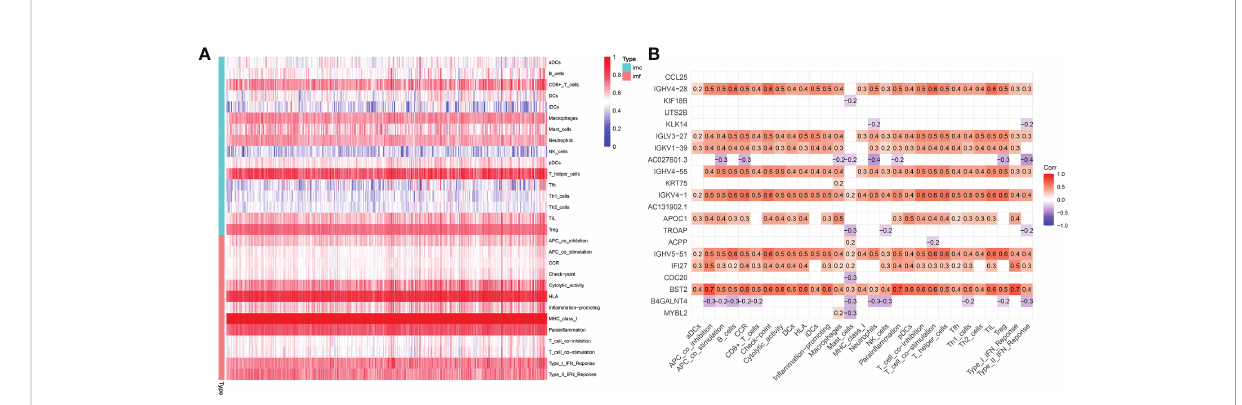
FIGURE 11 Immune microenvironment in TCGA-PRAD cohort. (A) Enrichment degree of immune cells and pathways in PRAD patients. (B) Association between prognostic-related DEGs and immune cells or pathways (DEGs: differential expression genes between high-risk and low-risk groups; red: positively correlated, violet: negatively